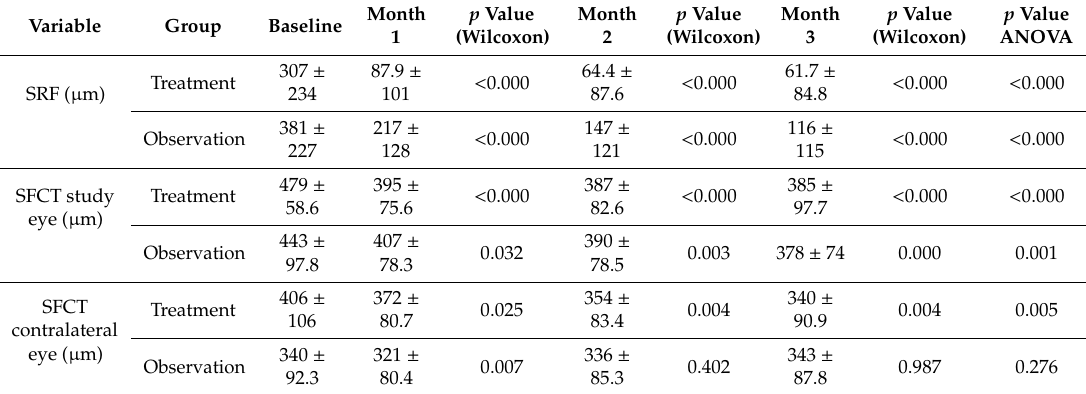
Table 2. Changes in the SRF height and SFCT from baseline through month three for both treatment and observation groups.